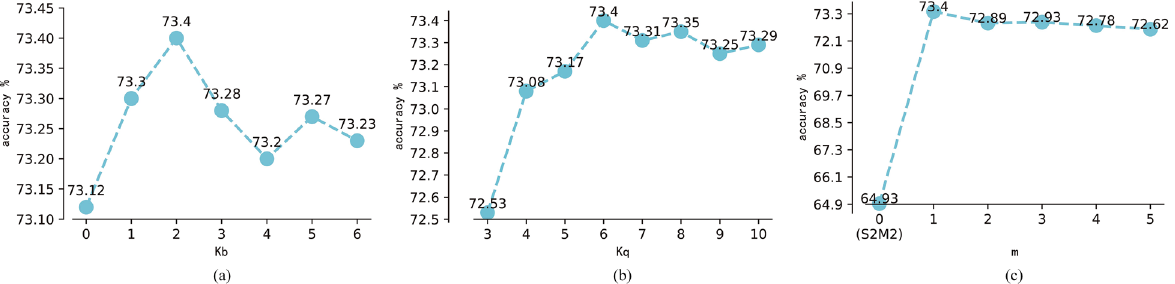
Figure 5. The effect of hyperparameter k b , k q and m on miniImageNet with 5-way 1-shot setting. ( a ) The effect of hyperparameter k b . ( b ) The effect of hyperparameter k q . ( c ) The effect of hyperparameter m